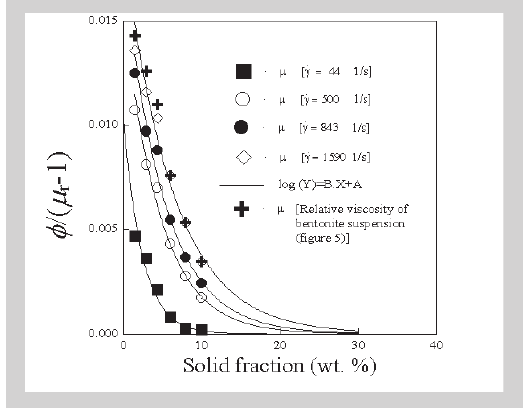
Figure 9 (left above): Evolution of f /( m r - 1) as a function of bentonite concentration (wt. %). Figure 10 (right above): Viscosity of oil-in-water emulsions loaded with ben- tonite versus shear rate and comparison with model curves of Quemada. Effect of bentonite concentration and aging time (26 vol. % of paraffin oil (E1 emulsion)). Figure 11 (right below): Viscosity of oil-in-water emulsions loaded with bentonite versus shear rate and comparison with model curves of Quemada. Effect of bentonite concentration and aging time (42 vol. % of paraffin oil (E2